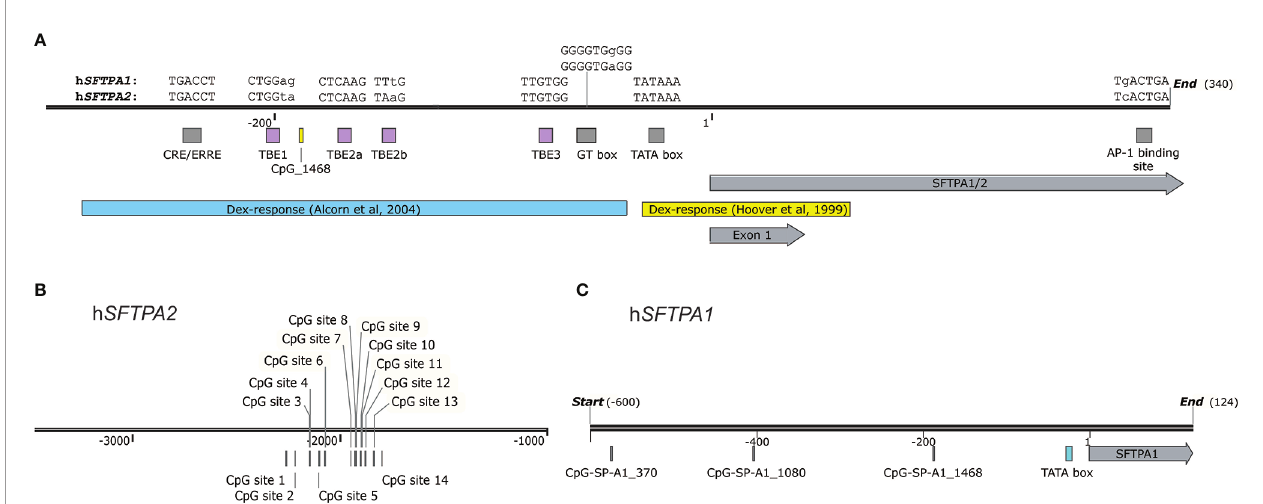
FIGURE 4 | (A) A map of the promoter region of the human SP-A genes (-300 to +340) drawn to scale. Elements in a yellow box are studied in h SFTPA1 and the ones in blue boxes in h SFTPA2 . Grey boxes indicate regulatory elements found in both genes. The differences in sequences are demarcated by lowercase letters. The dexamethasone response elements are based on the transfection studies by Hoover et al. with h SFTPA1 promoter constructs in H441 cells (45) and by Alcorn et al. with h SFTPA2 constructs in A549 cells (110). (B) The relative positions of the methylation island identi fi ed in an enhancer region of h SFTPA2 is shown (49). (C) The relative positions of CpG sites upstream of the hSFTPA1 gene is according to Lin et al.